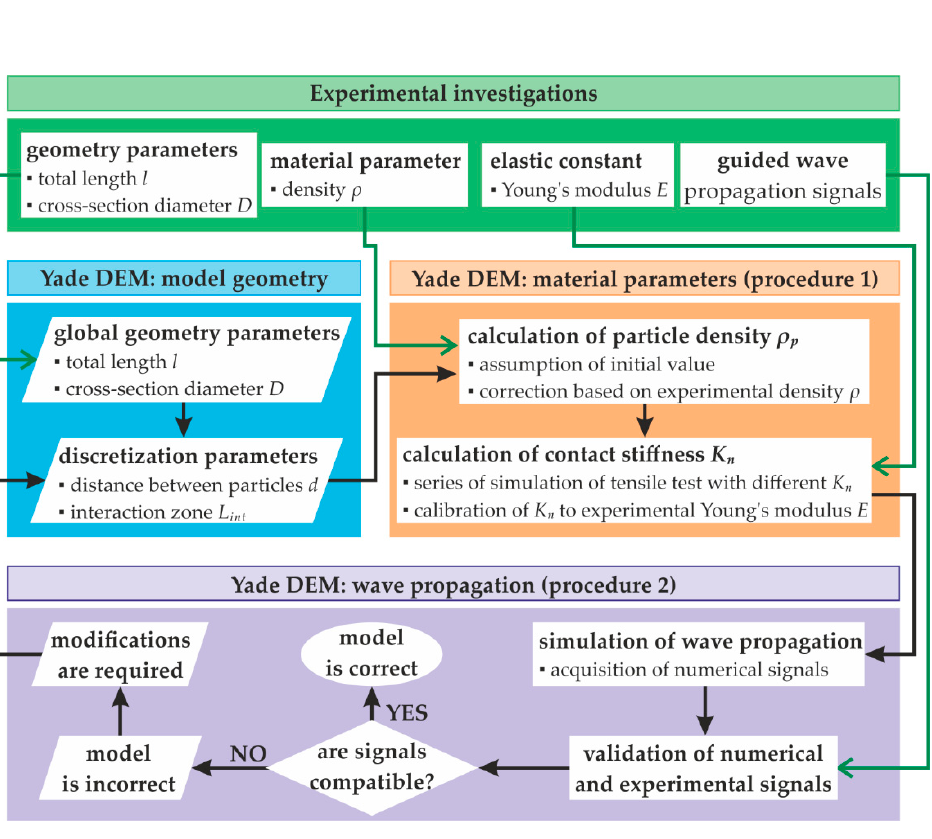
Figure 3. A scheme of building a DEM model of a rod with a circular cross-section for wave propagation using Yade DEM.